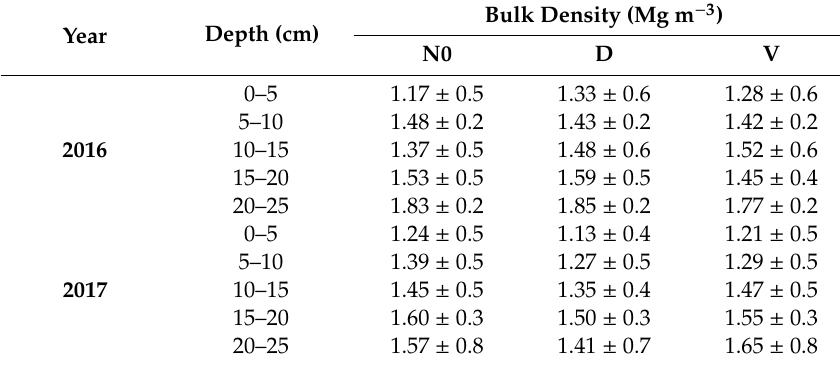
Table 3. Mean bulk density measured in the two experimental fields. Non-fertilized plot (N0), digestate injection (D) and digestate + inhibitor injection (V). The displayed data were calculated as mean across all blocks ( n = 3). ± mean standard